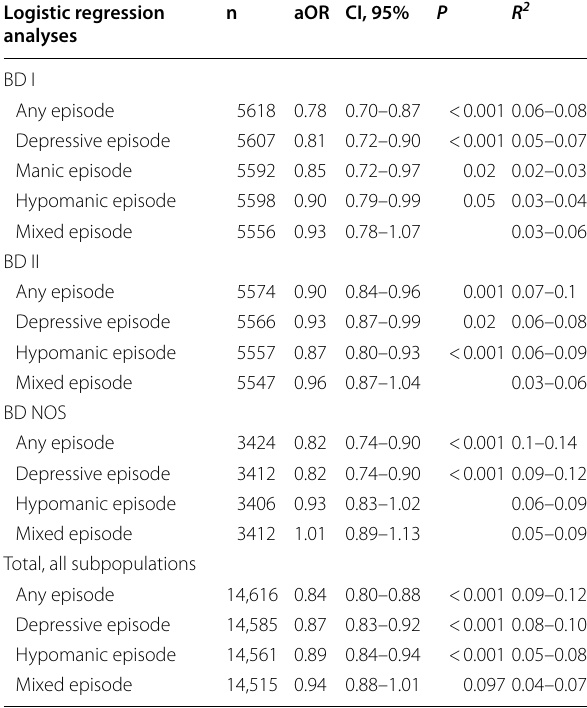
Adjusted odds ratios (aOR) estimating differences for patients in counties with high lithium prevalence compared with counties with low lithium prevalence. The aOR can be interpreted as the decreased odds for a mood episode in the population when the lithium prescription rate is greater by 10% points